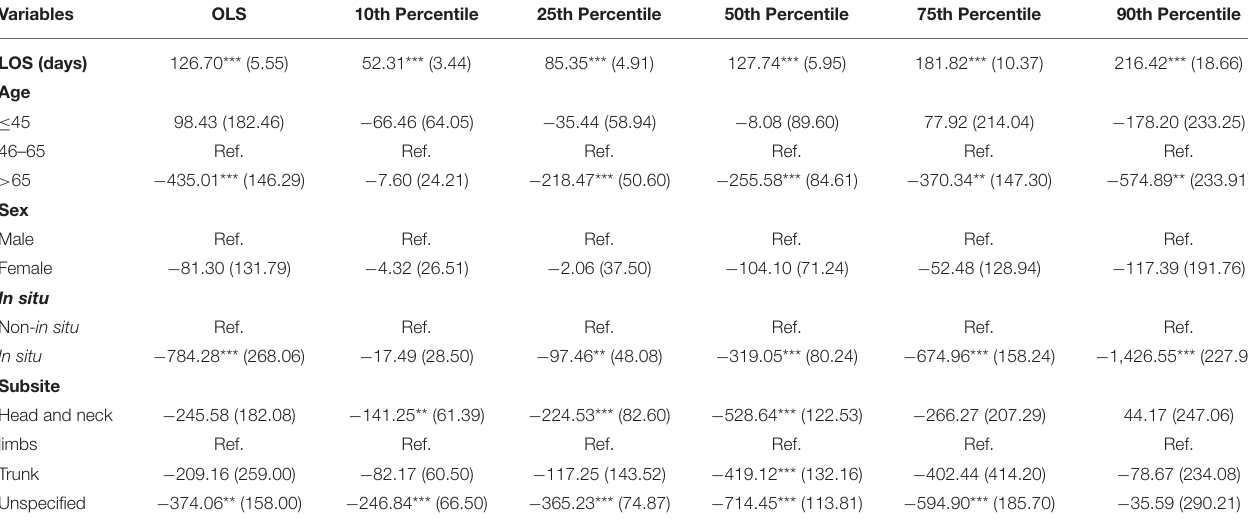
TABLE 3 | Quantile regression versus linear regression for the hospitalization costs of patients with melanoma undergoing surgery in Hunan.